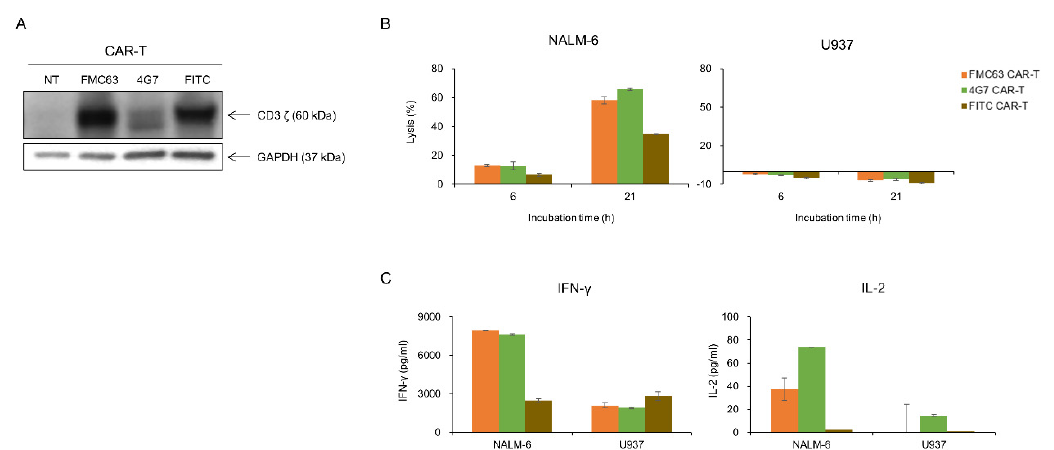
Figure 4. FMC63 and 4G7 CAR T cells e ff ectively responded to CD19-positive NALM-6 cells. ( A ) After transduction of anti-CD19 CAR lentiviruses into primary human T cells, CAR expression was confirmed through the Western blot. Anti-human CD3 antibody was used to detect CD3 ζ of CAR. ( B ) Tumor-killing ability of FMC63, 4G7, and FITC CAR T cells against luciferase-expressing NALM-6 and U937. FMC63, 4G7, and FITC CAR T cells (2 × 10 5 cells) were co-cultured with luciferase-expressing NALM-6 (2 × 10 4 cells) or U937 (2 × 10 4 cells) for indicated incubation times at the E:T ratio 10:1. Then, luminescence values were measured. ( C ) FMC63, 4G7, or FITC CAR T cells (1.5 × 10 5 cells) were co-cultured with NALM-6 cells (1.5 × 10 4 cells) or U937 cells (1.5 × 10 4 cells) for 21 h at the E:T ratio 10:1. The amount of IFN- γ and IL-2 secreted by CAR T cells was measured through the ELISA assay.